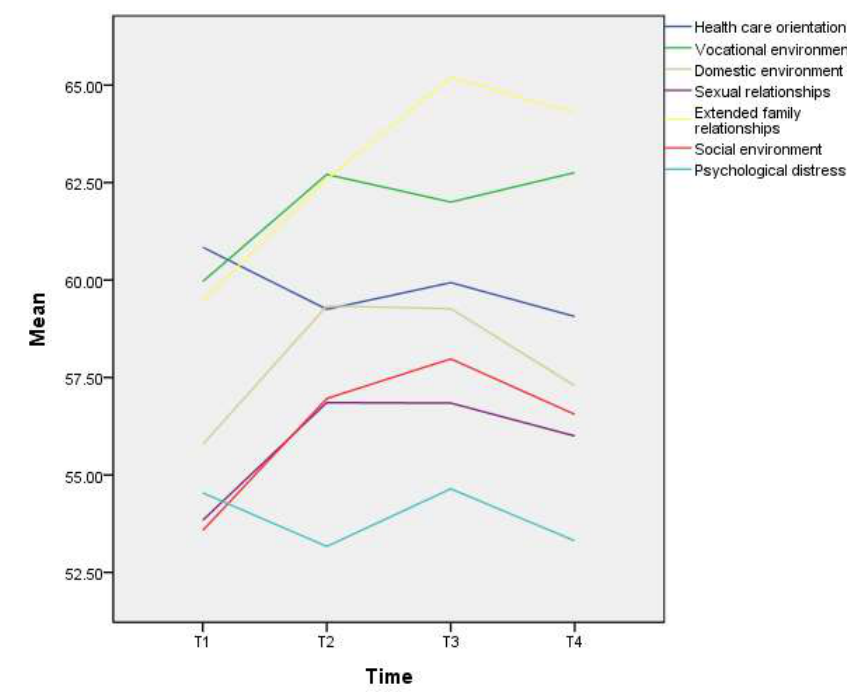
Figure 2. Oral cancer patients’ seven domains of psychosocial adjustment.